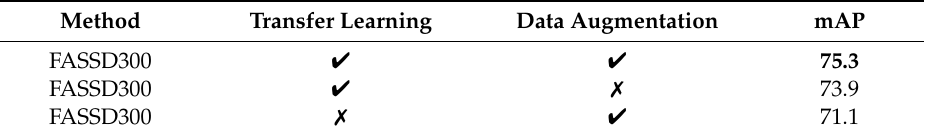
Table 7. Results of the ablation study on